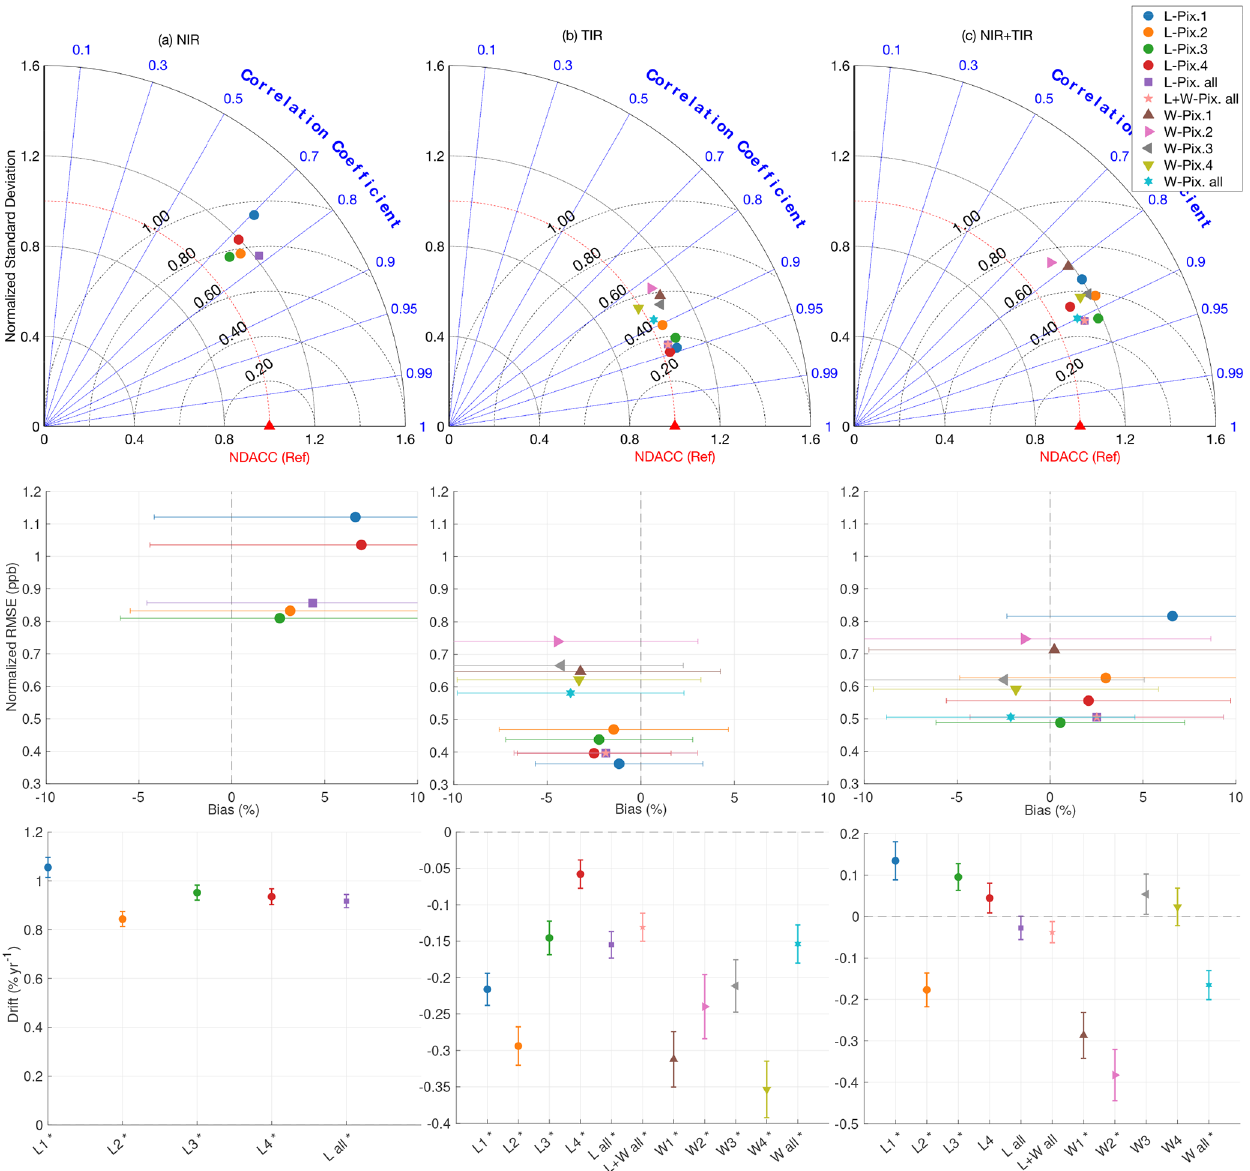
Figure 11. The normalized Taylor diagram (top row), normalized RMSE vs. average percent bias (middle row), and drift (bottom row) for all MOPITT pixel measurements compared to NDACC. In the modified Taylor diagram, the normalized standard deviation (NSTD) is on the radial axis, the correlation coefficient value is on the angular coordinate, and the black dashed lines show the normalized CRMSE with respect to NDACC as the reference point. Column (a) shows the results for the NIR product, column (b) for the TIR product, and column (c) for TIR–NIR. In row 2, the horizontal bars represent the 1 σ standard deviation of the biases, and in row 3, the vertical bars are drift fit uncertainties (1 σ ). In row 3, the asterisks ( ∗ ) on the x -axis labels indicate drifts with significance levels of 95% or greater. The MATLAB SkillMetrics toolbox (https://github.com/PeterRochford/SkillMetricsToolbox, last access: 1 September 2019) was used to create the Taylor